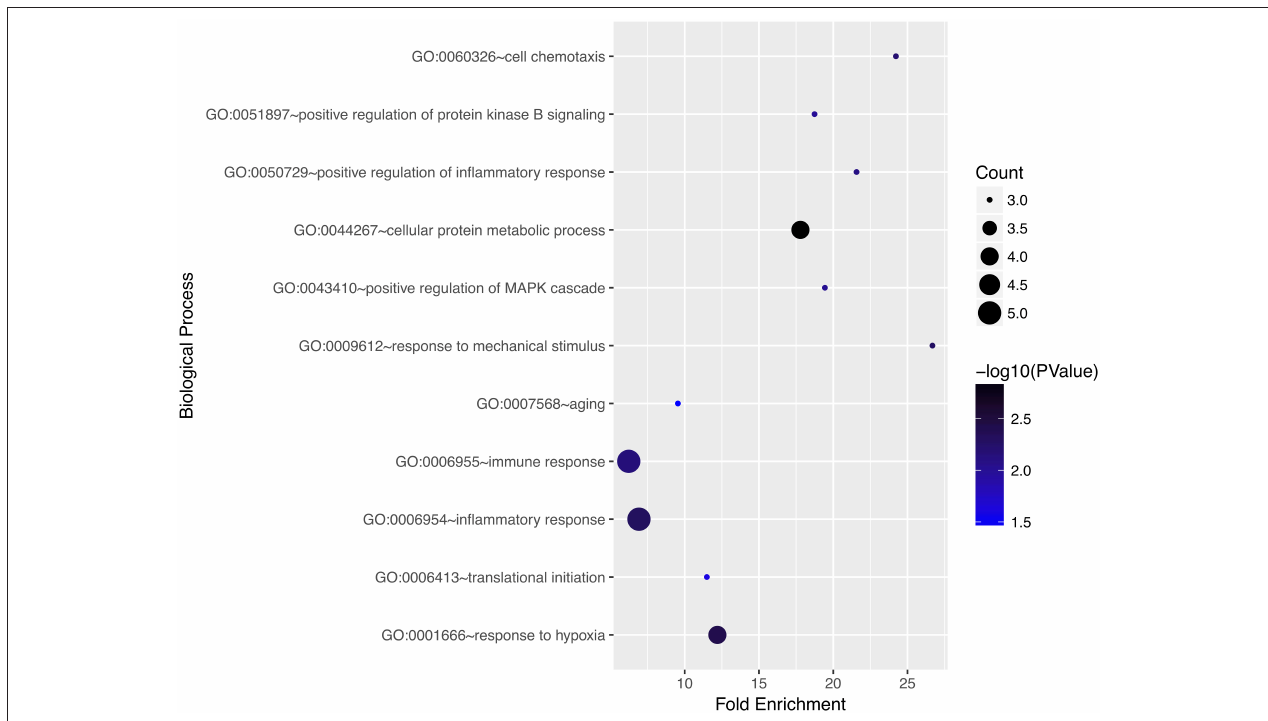
FIGURE 2 | Gene ontology analysis for biological process of genes involved in the ceRNA network in ACC.